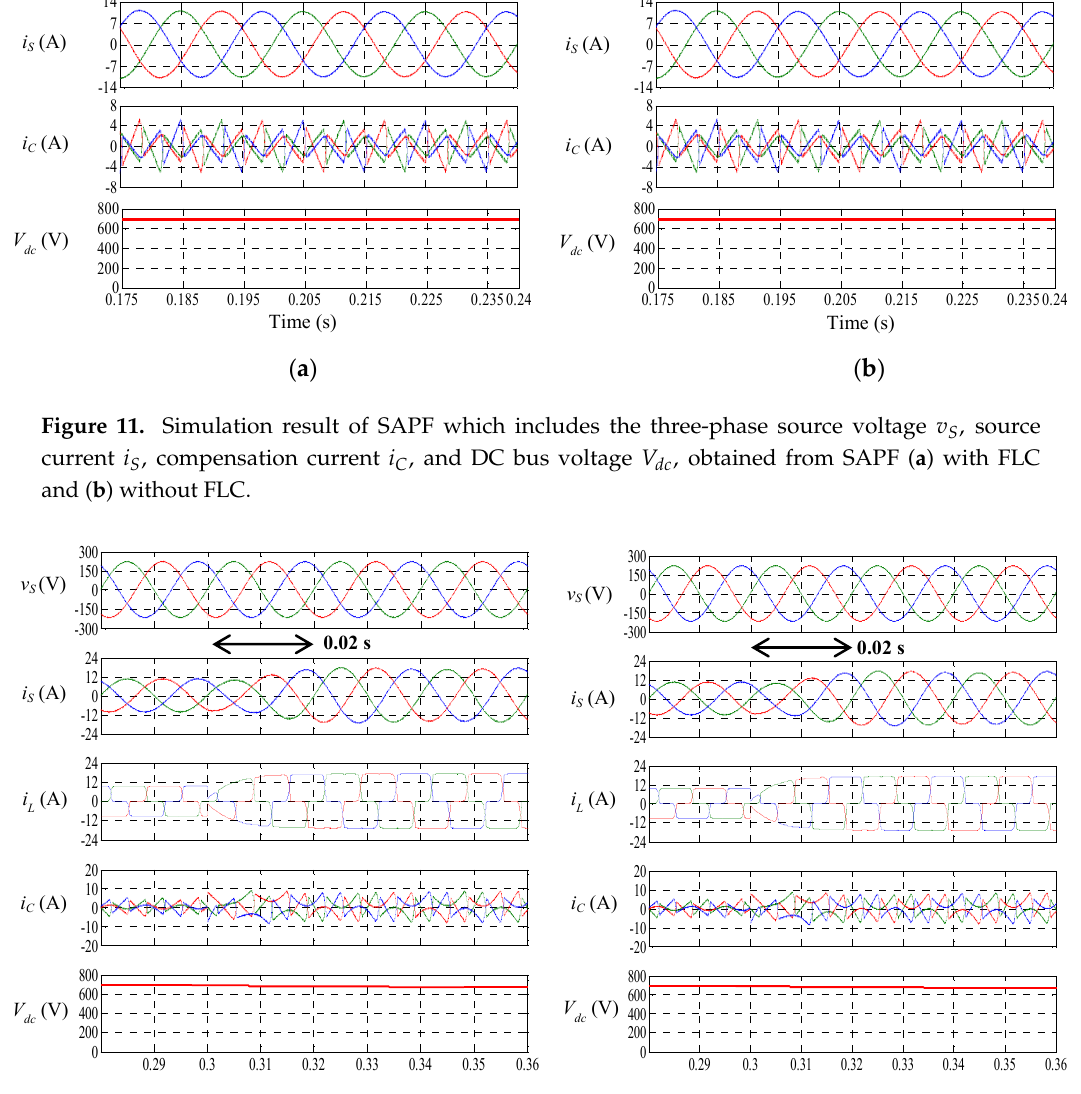
Figure 12. Simulation result of SAPF under transient-state condition of low to high current which includes the three-phase source voltage v S , source current i S , compensation current i C , and DC bus voltage V dc , obtained from SAPF ( a ) with FLC and ( b ) without